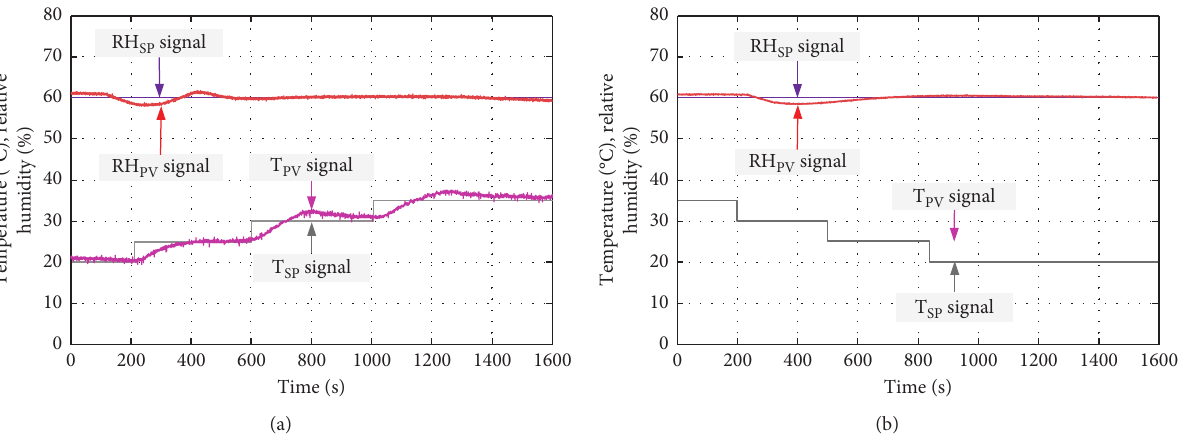
Figure 14: Process response of temperature at RH constant. (a) Upward temperature setpoint ( ° C). (b) Downward temperature setpoint ( °